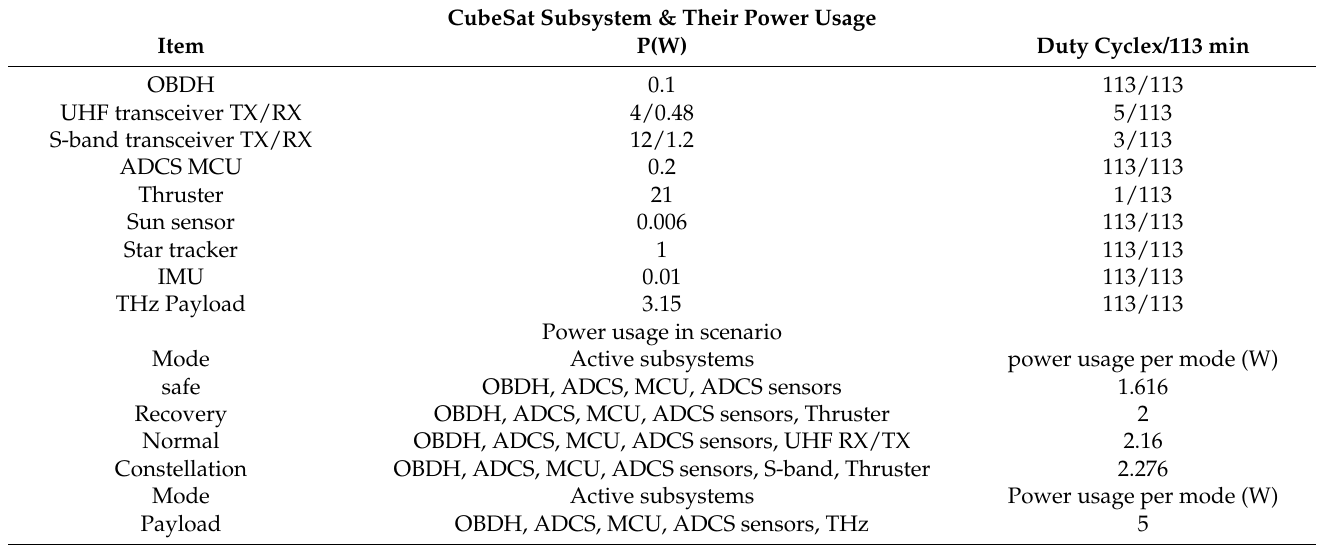
Table 3. CubeSat power budget.